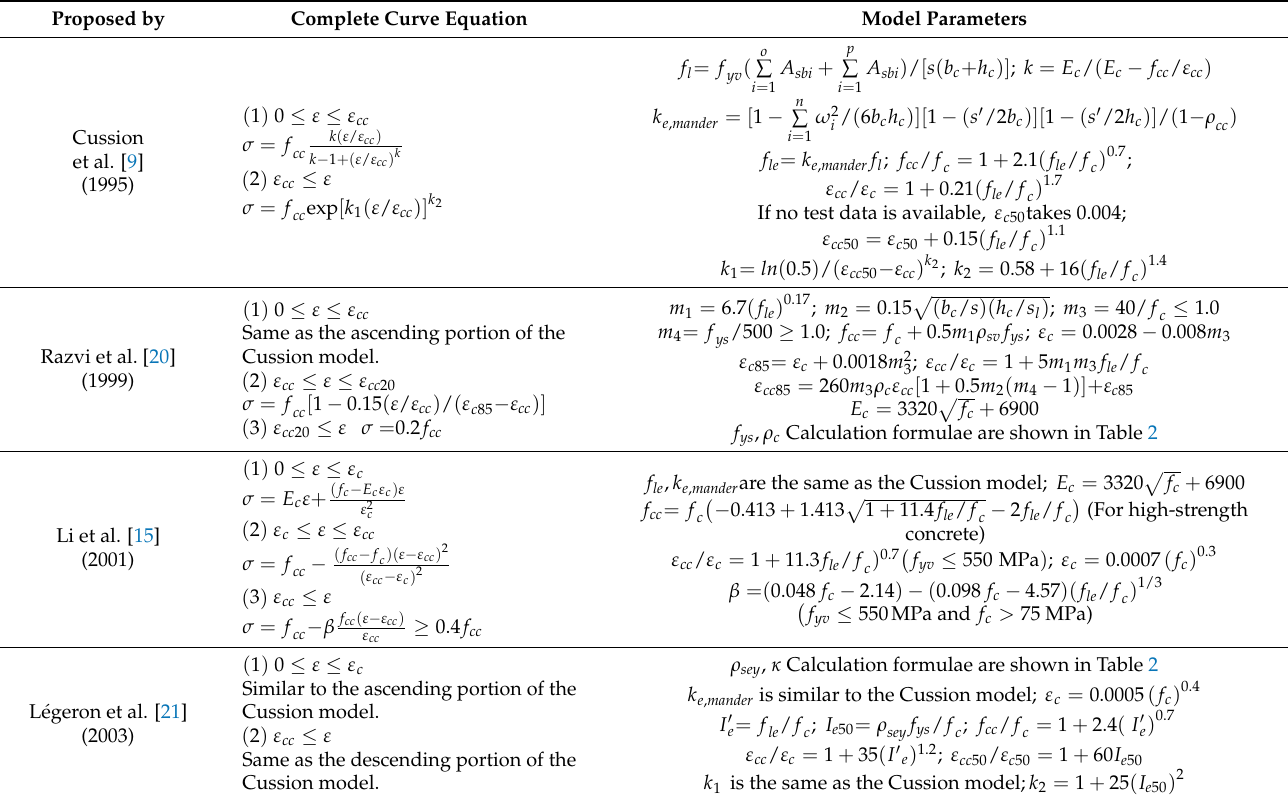
Table 1. Ties-confined high-strength axial compressive stress–strain models.